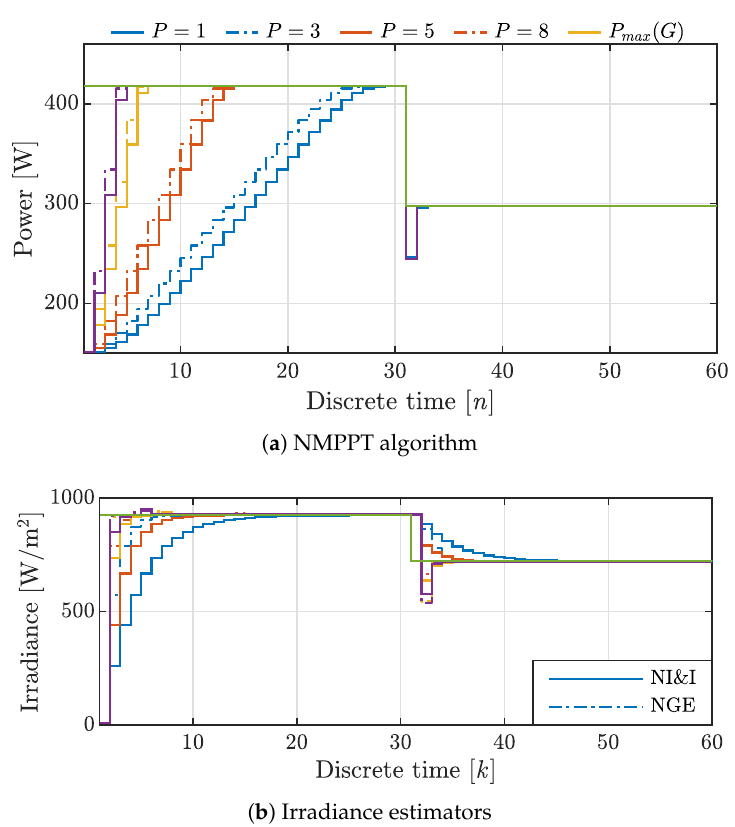
Figure 7. Performance of the proposed algorithm for different values of P